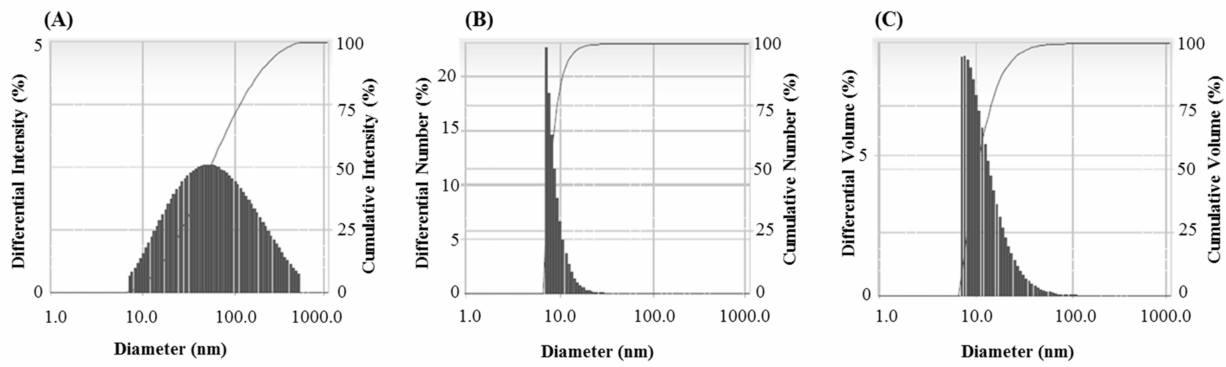
Figure 6. Particles size distribution of P. nicotinovorans MAHUQ-43-mediated synthesized AgNPs according to intensity ( A ), number ( B ) and volume ( C ).